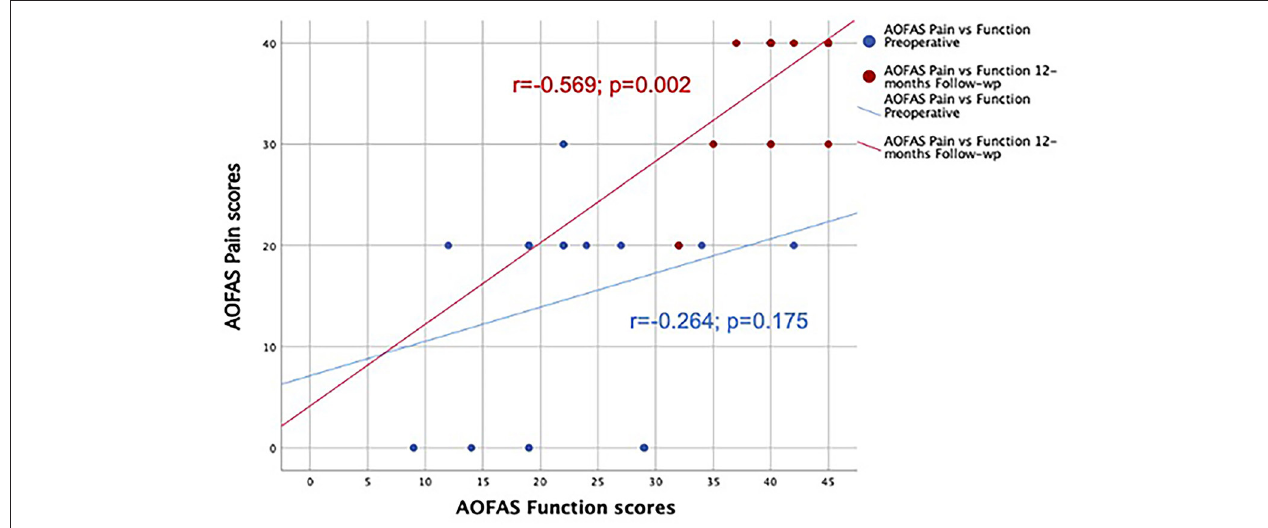
FIGURE 3 | Positive correlation between AOFAS Pain and function scores at 12-month follow-up, but not at the preoperative assessment. TABLE 3 | Dimensions of the AOFAS function subscale according to the foot type. AOFAS Function Subscale Pronated Neutral